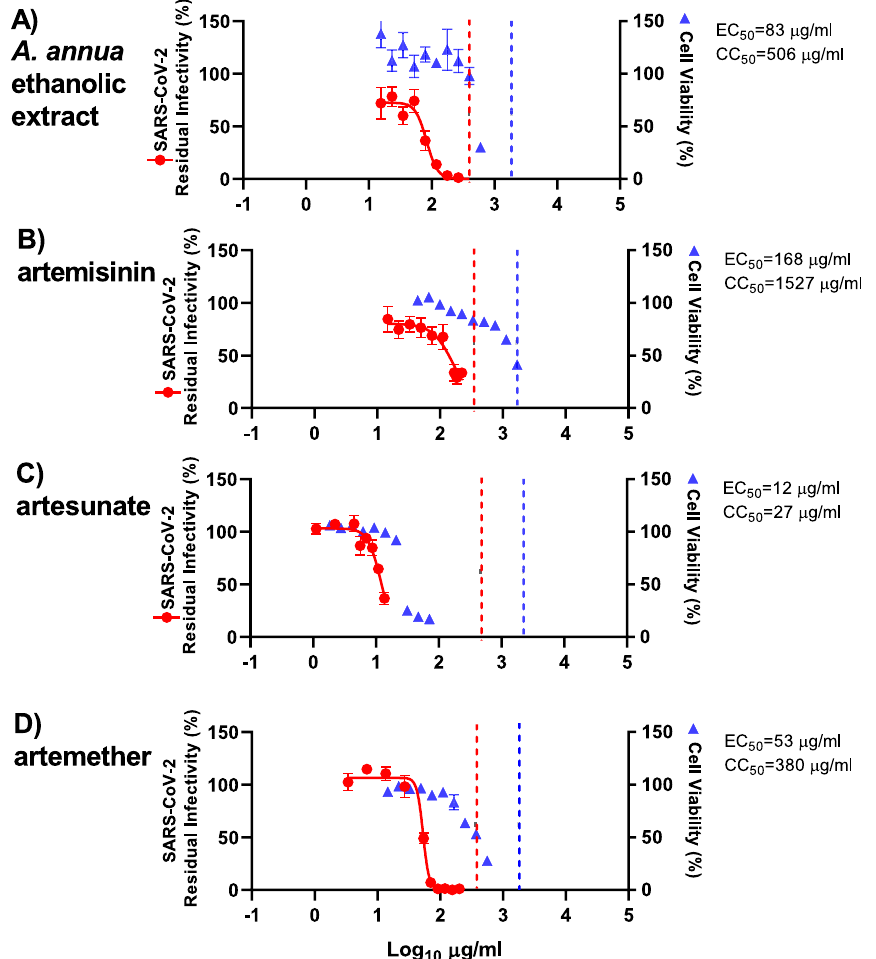
Figure 5. Treatment efficacy of A. annua extract and compounds against SARS-CoV-2 in a concentration– response antiviral treatment assay in A549-hACE2 cells. A549-hACE2 cells seeded the previous day in 96-well plates were infected with SARS-CoV-2 and directly treated with the specified concentrations of A. annua ethanolic extract ( A ) or compounds artemisinin ( B ), artesunate ( C ), and artemether ( D ). After a 2-day incubation, infected cells were visualized by immunostaining for SARS-CoV-2 spike glycoprotein and counted automatically as described in “Materials and methods”. % residual infectivity for individual wells was calculated by relating counts of infected treated wells to the mean count of 14 infected nontreated control wells. Datapoints (red dots) are means of seven replicates with SEM obtained in one representative experiment. Sigmoidal dose response curves (red lines) were fitted and EC 50 values were calculated in GraphPad Prism as described in “Materials and methods”. % Cell viability and CC 50 values were determined in replicate assays without infection with SARS-CoV-2 as described in “Materials and methods”. Datapoints (blue triangles) are means of 3 replicates with SEM obtained in one representative experiment. The dotted red/blue lines indicate the concentrations at which an antiviral effect (< 70% residual infectivity)/cytotoxic effect (< 90% cell viability) due to DMSO is expected according to Figure